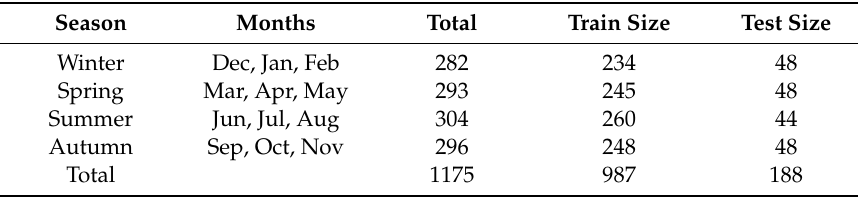
Table 5. Summary of seasonal dataset.